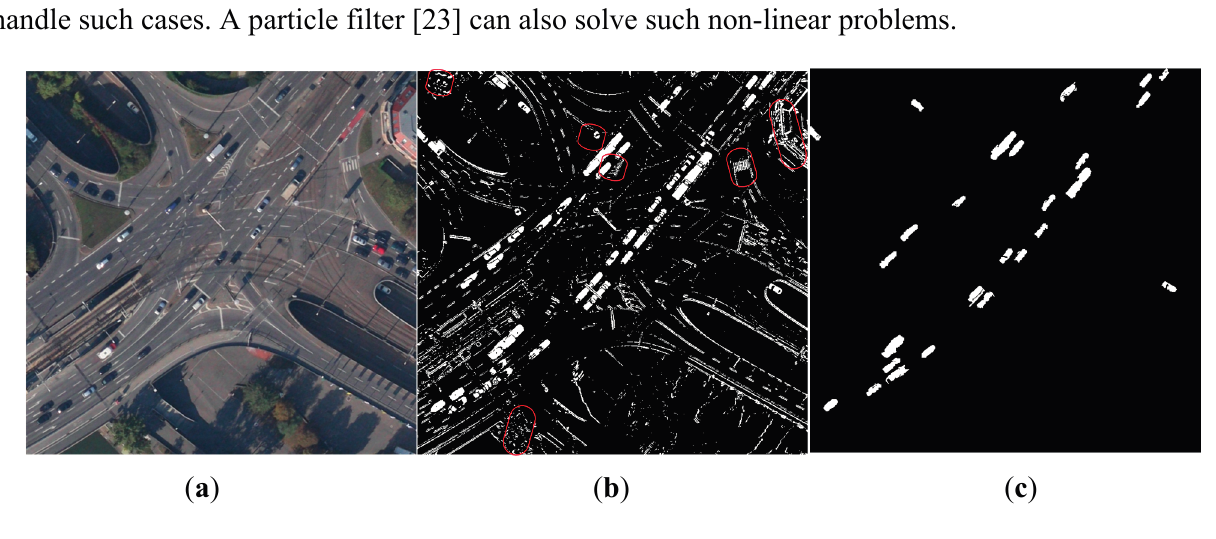
Figure 1. The comparison of moving detection results by different methods. ( a ) Original image ( b ) Moving detection with false alarms in red circles when using one affine model to describe the scene ( c ) Moving detection by our